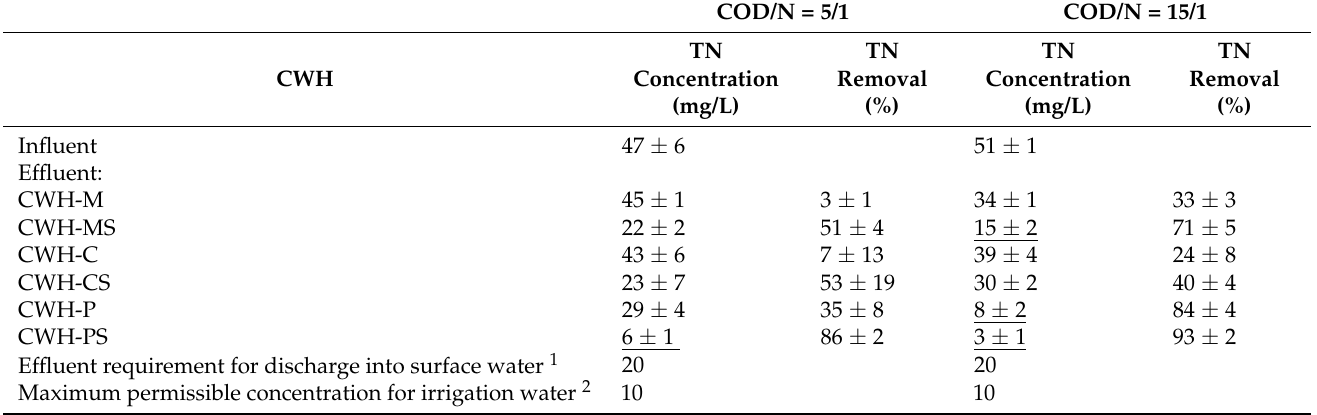
Table 1. Average TN influent and effluent concentrations (mg/L) and removal (%) with standard error in CWH over the experimental period at COD/N ratio of 5/1 and 15/1, in comparison with the effluent requirements for discharge into surface water and reuse for irrigation water. Underlined values meet the effluent quality requirements. CWH-MS and CWH-M indicate mineral wool with and without plants, respectively. CWH-CS and CWH-C indicate cocopeat with and without plants, respectively. CWH-PS and CWH-P indicate pumice with and without plants,